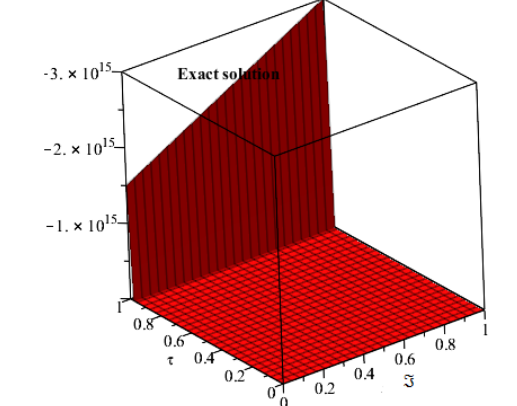
Figure 15. Exact solution of Example 5 at β = 1.